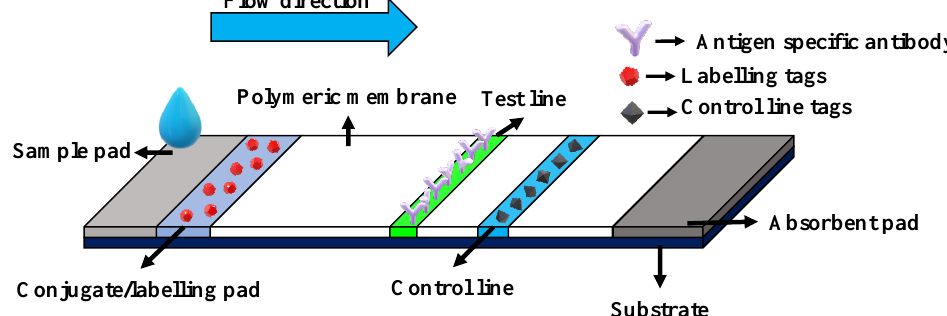
Figure 6. Schematic of a general lateral flow immunoassay-based device. Several LFIA-based sensors have been reported for phytopathogen detection, where some key recent studies include (i) a double enhanced LFIA containing magnetic and gold nanoparticles (MNPs and AuNPs) for the detection of potato virus X (PVX; genus Potexvirus ) [79], where the concentration of analyte was increased in the samples using conjugates of MNPs with specific antibodies and visibility of the label was increased through MNP aggregation caused by AuNPs. A detection limit of 0.25 ng/mL was observed as compared to 8 ng/mL in case of non-enhanced LFIA with operation time of 10 to 15 min; (ii) a multiplex LFIA for the simultaneous determination of three mycotoxins (toxic metabolites produced by fungi) in corn, rice, and peanut [80]. Here the LFIA strip consisted of three test lines, one for each mycotoxin, and exhibited a detection limit of about 10 µ g/kg to 50 µ g/kg; (ii) another multiplex LFIA-based sensor for mycotoxin ( aflatoxin B1 , zearalenone and deoxynivalenol ) determination in cereal crops (maize and wheat samples) with a visual detection limit of 0.03 to 10 µ g/kg [47]; (iv) an Ag-enhanced LFIA for the detection of potato leafroll virus [46], where the Ag enhancement is based on the reduction of Ag ions on the surface of AuNP (used for labeling) resulting in a significant increase of initial AuNP-caused coloration. A detection limit of 0.2 ng/mL and an operation time of 15 min was observed; (v) an LFIA device for detecting ochratoxin A (a mycotoxin) in wines and grapes, where a gold-silver enhancement scheme was implemented. A detection limit of 0.9 µ g/L was achieved with an assay time of 10 min